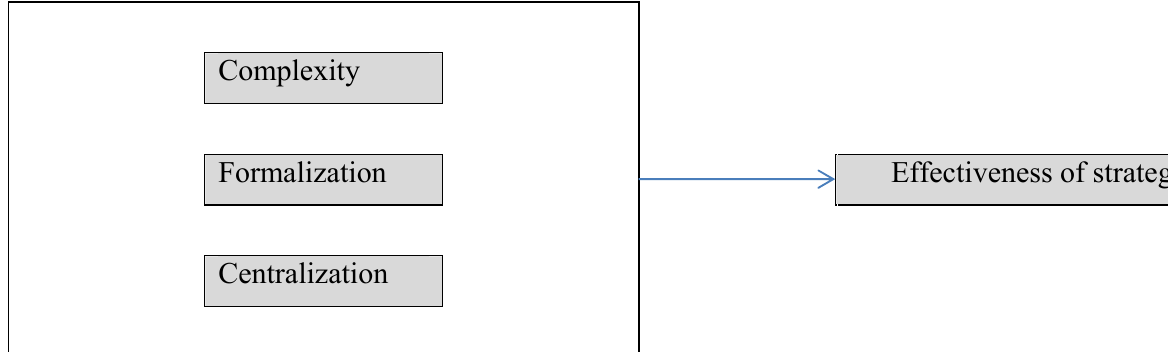
Fig. 1. Conceptual Model of the Research (Robbins,